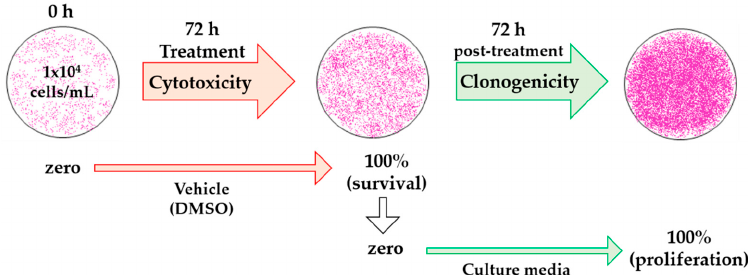
Figure 4. Schematic diagram of the analysis with dimethyl sulfoxide (DMSO) treatment for cytotoxic and clonogenic determinations. The optical density (OD) of initially plated cells was measured as zero (OD zero ) in the cytotoxicity assay, OD after 72 h of treatment with vehicle was considered as 100% cell survival (OD blank ). In the clonogenic assay, OD at 100% cell survival was considered as zero, since these were the initial cells (OD zero ), and OD at 72 h vehicle post-treatment was measured as 100% cell proliferation (OD blank